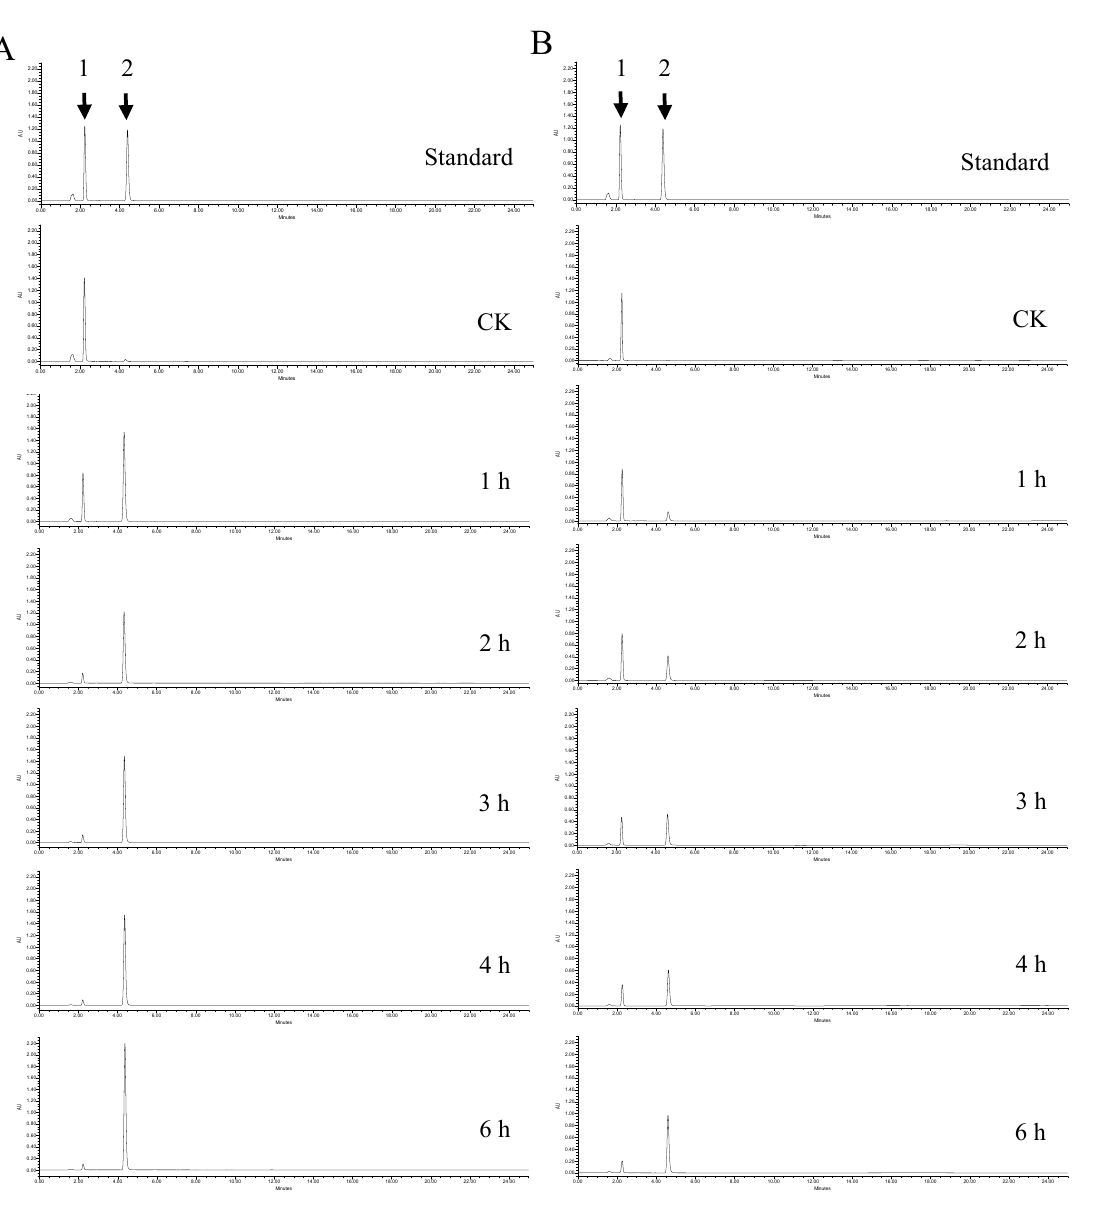
Figure 10. High-performance liquid chromatograms of the reaction solution from different time points in the biphase conversion system ( A ) and the uniphase conversion system ( B ). Standard, (1) polydatin; (2) resveratrol. CK, reactions without enzyme; 1–6 h, different time points after the enzyme